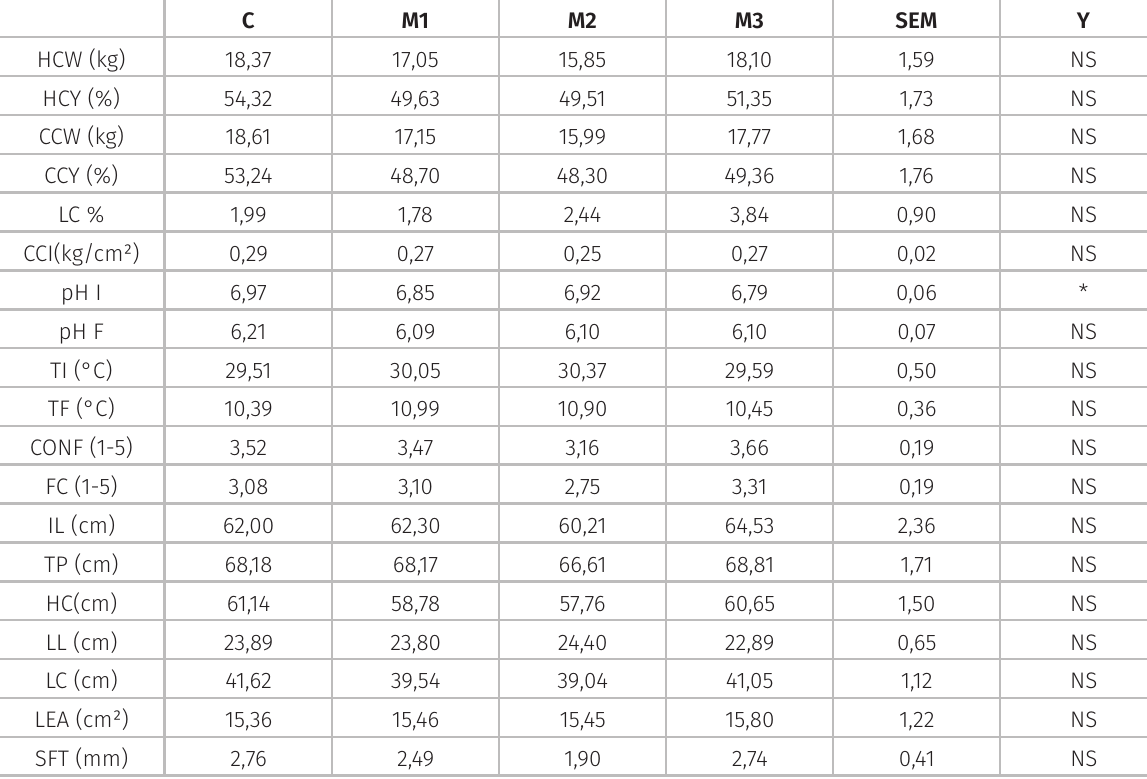
Table IV. Carcass characteristics of lambs fed with macadamia